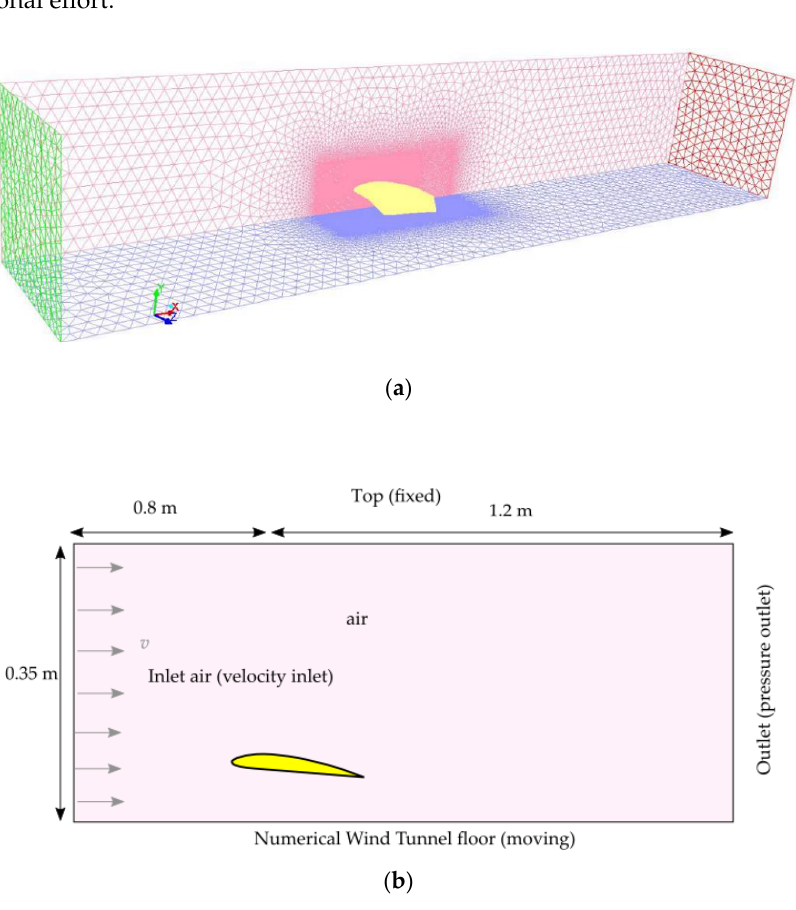
Figure 4. ( a ) Mesh visualization around the compound wing. ( b ) Computational domain dimensions and main boundary condition applied.